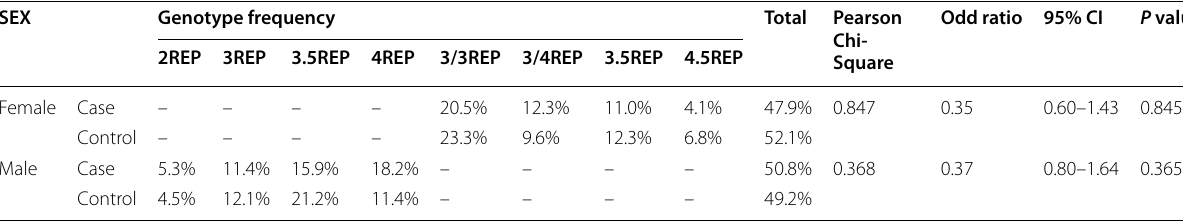
Table 2 The genotype frequency of MAOA uVNTR